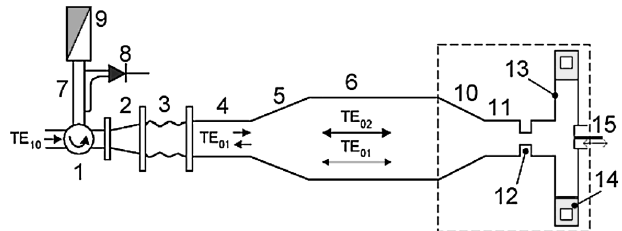
FIG. 9. Schematic diagram of a microwave compressor with mode into the plasma switch based on conversion of the TE 02 mode: (1) circulator; (2) TE rectangular to TE (cid:3) mode TE 01 10 01 ! TE (cid:3) converter; (3) TE (cid:3) mode converter; (4) input and output 11 01 waveguides; (5) input horn; (6) cylindrical waveguide cavity; (7) directional coupler; (8) detector; (9) matched load; (10) cone taper; (11) round waveguide section; (12) diaphragm; (13) step- wise widening of circular waveguide; (14) ring-shaped quartz gas-discharge tube; (15) adjusting